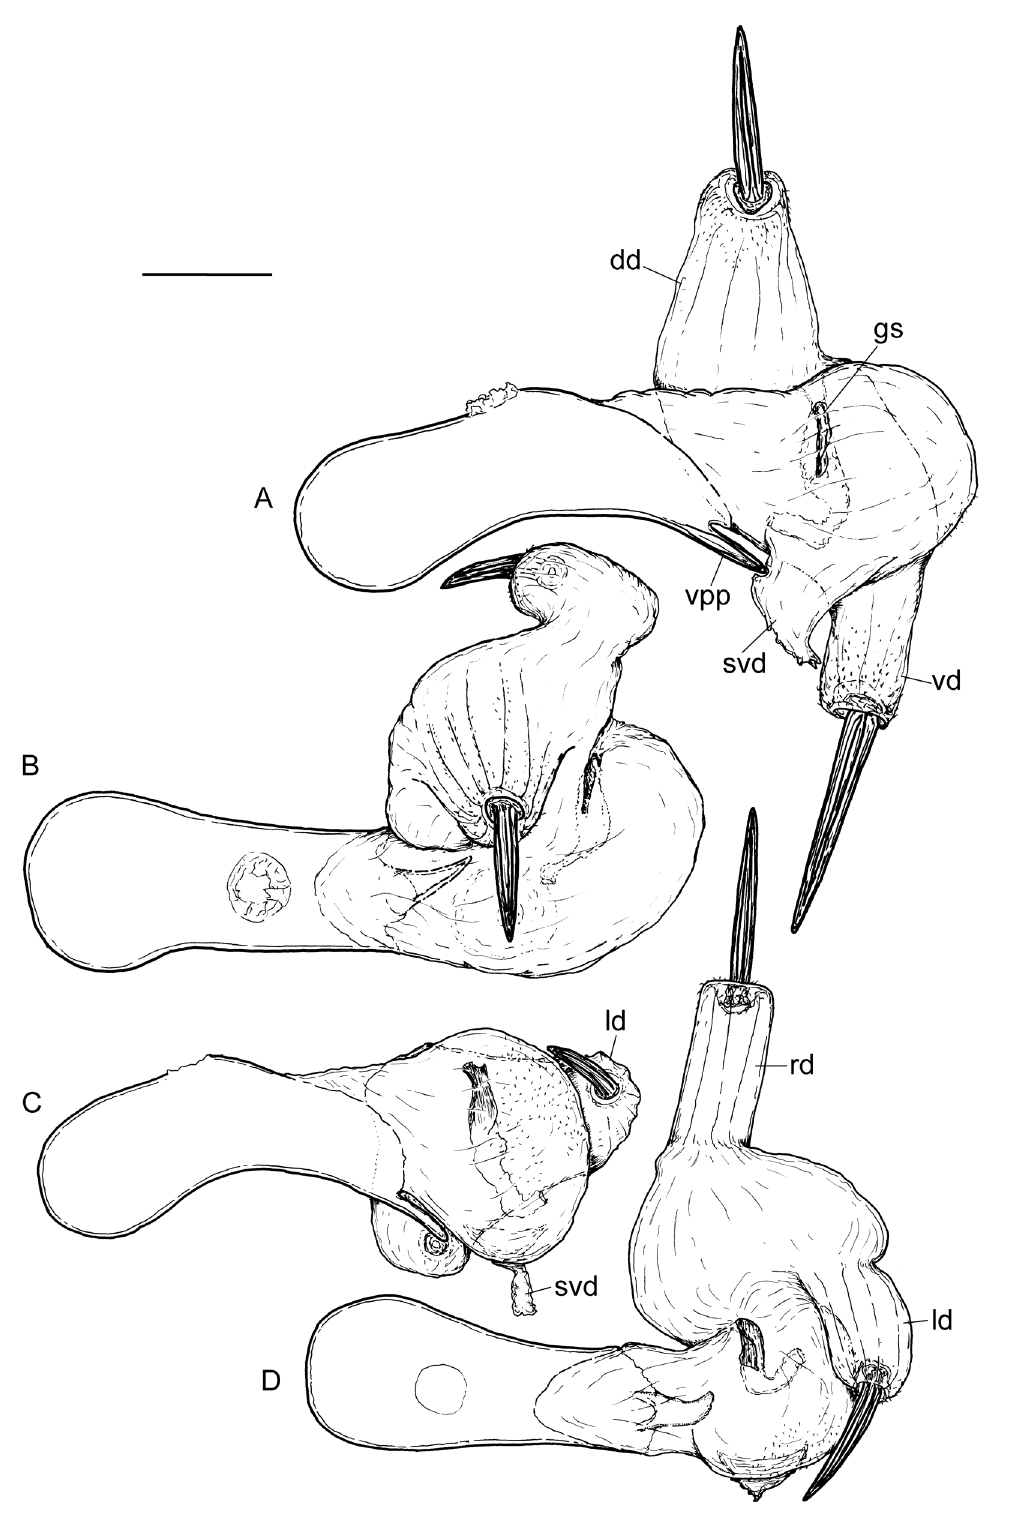
Fig. 6. Phalli with vesica everted of Phtheochroa spp. A–B . P. alpinana sp. nov., France, Alpes Maritimes, holotype. – C–D . P. apenninana sp. nov., Italy, Gran Sasso National Park, holotype. A, C: left. B, D: dorsal. Abbreviations: dd = dorsal diverticulum; vd = ventral diverticulum; other abbreviations as in Fig. 5. Scale bar = 250